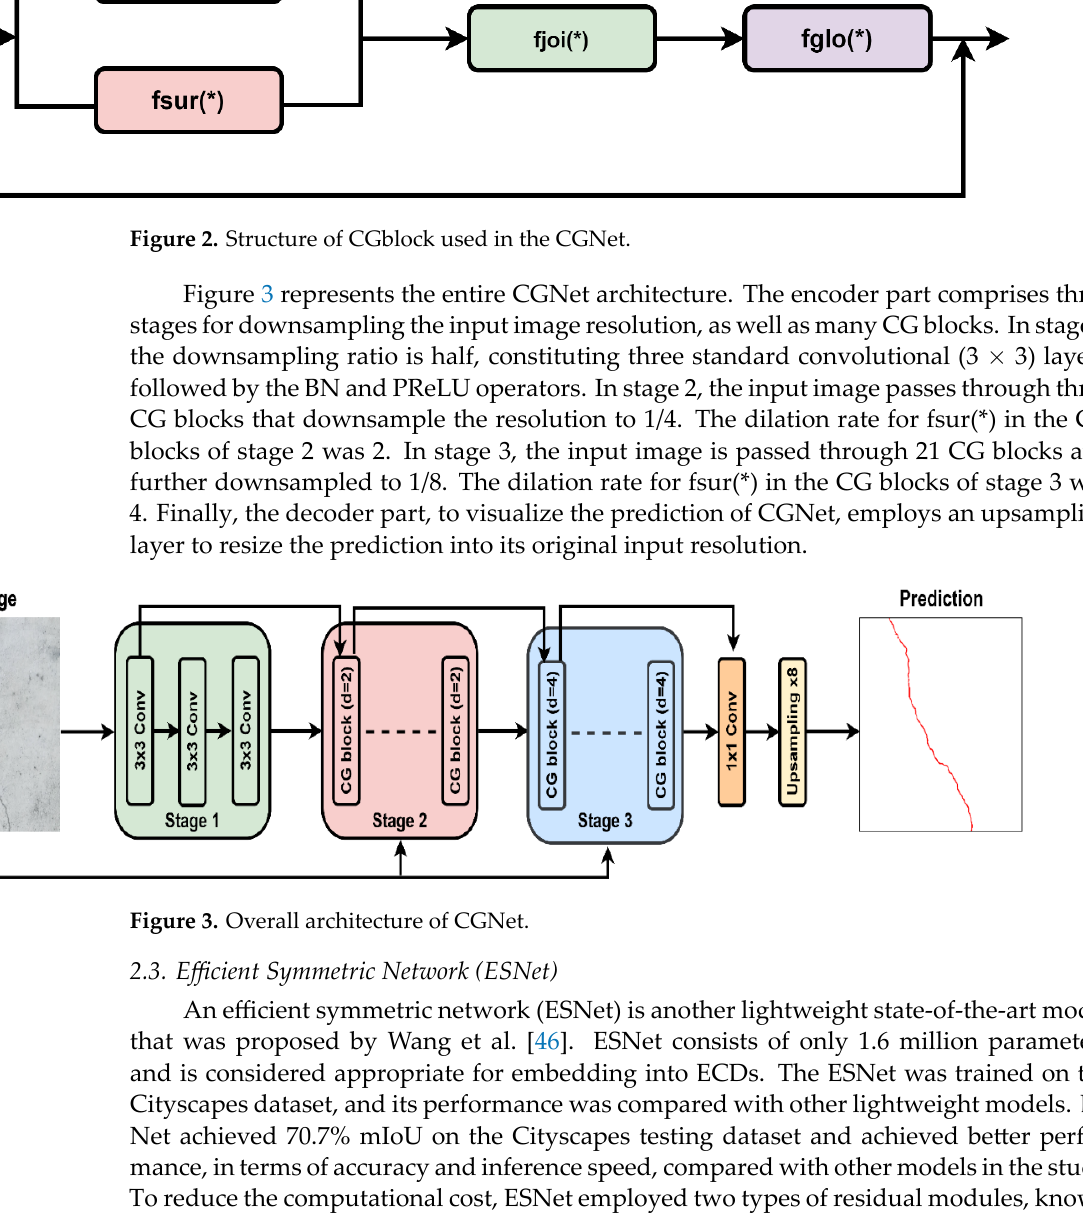
Figure 3. Overall architecture of CGNet.